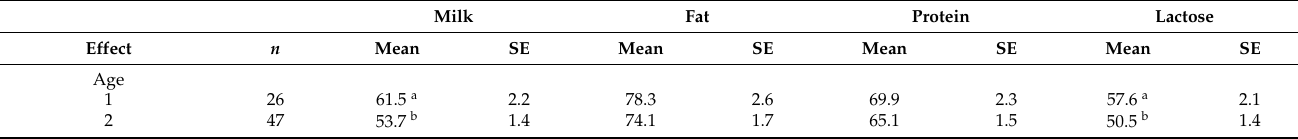
Table 6. Least-squares means (Mean) and standard errors (SE) of lactation persistency (%) 1 of milk, fat, protein, and lactose yields, for different ewe age, litter size, coat colour, and days in twice-a-day (TAD) milking at Kingsmeade farm during 2021–2022